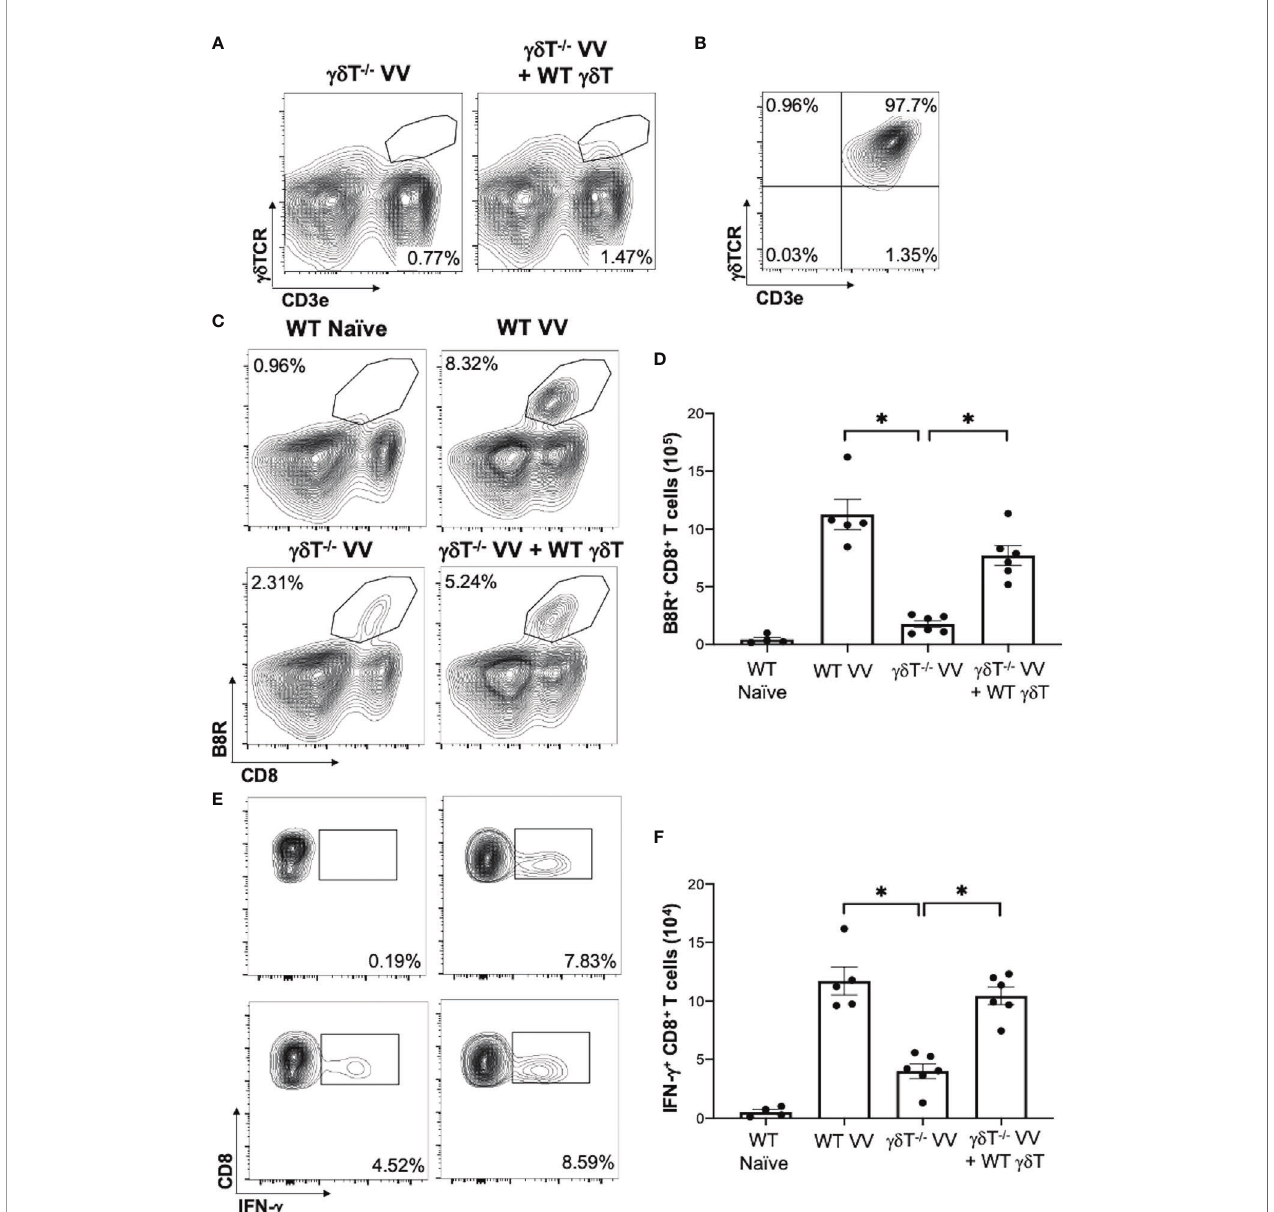
FIGURE 2 | gd T cells is required for CD8 + T cell response to VV. 5 x 10 6 pfu of VV were injected intraperitoneally into wild-type C57BL/6 (WT) or d TCR -/- mice ( gd T -/- ). Concurrently, a different population of d TCR -/- mice were also adoptively transferred with 1 x 10 6 WT gd T cells ( gd T -/- VV + WT gd T), followed by VV inoculation. (A) 3 days post-adoptive transfer and VV inoculation, there is a detectable, but nonsigni fi cant, population of gd T cells in the mesenteric lymph nodes. (B) Representative plot of puri fi ed gd T cells used for adoptive transfer. 7 days post-inoculation, the spleens were harvested and stained for B8R + CD8 + T cells by tetramer and IFN- g + CD8 + T cells by intracellular staining. (C) Representative FACS plots fi rst gated on CD8 + CD4 - T cells and then plotted against B8R + and CD8 + T cells for B8R + CD8 + T cells. (E) Representative FACS plots fi rst gated on CD8 + CD4 - T cells and then assessed for IFN- g expression. (D, F) Quanti fi cation of FACS plots. Values are mean ± SEM, representative of 3 independent studies, each with at least 3 biological replicates. ANOVA with post-hoc t-test, * P <